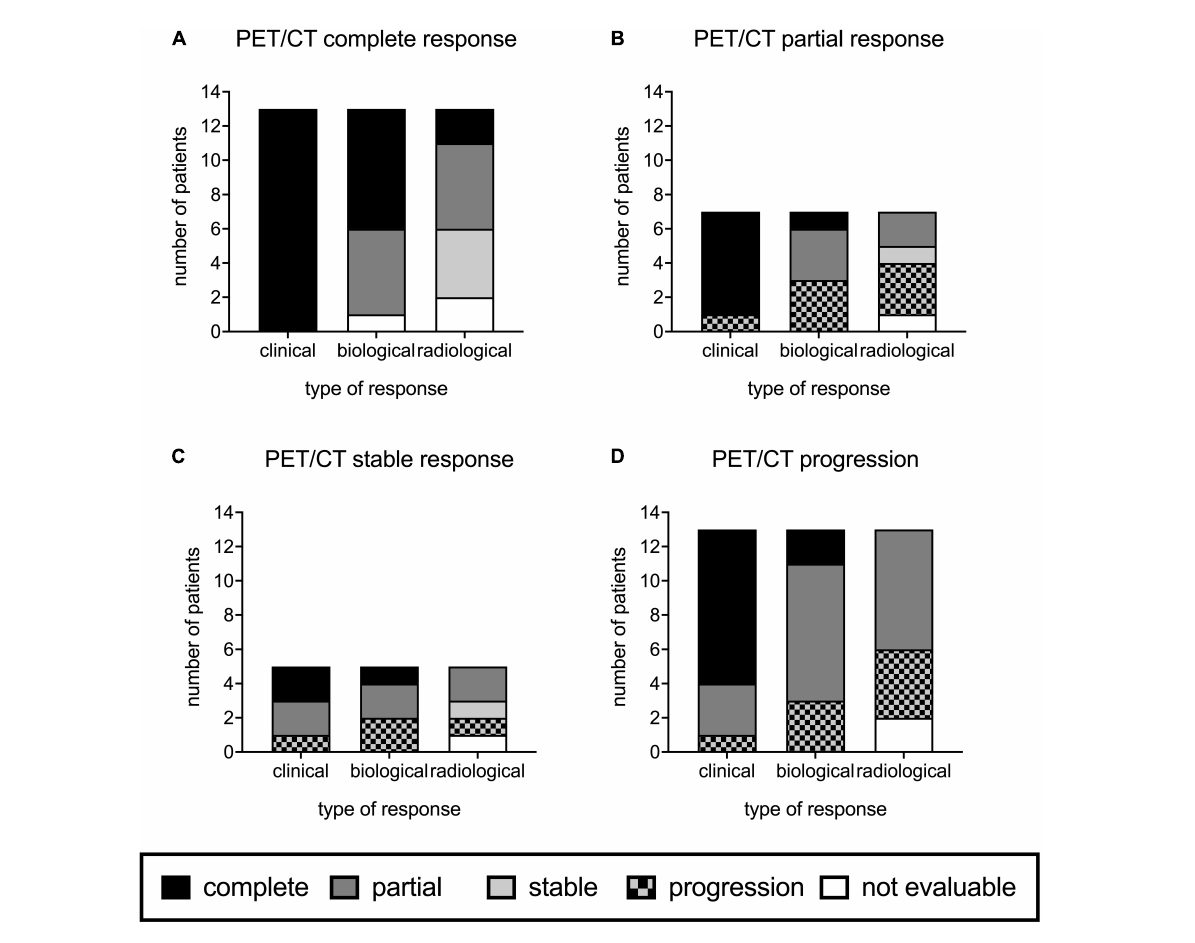
FIGURE2 Positron-emission tomography computed tomography (PET/CT) responses at M3 compared to those of conventional imaging, clinical examination, and biology in 38 onco-hematology patients. M3 PET/CT showed complete response in 13 patients (A) , partial response in 7 (B) , stable response in 5 (C) , and progression in 13 patients (D)